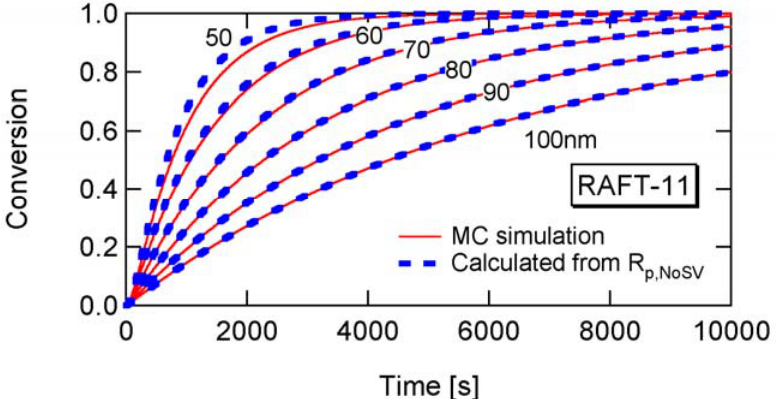
Figure 19. Conversion development of RAFT-11 with various particle sizes. The numbers in the figure show the particle diameter D < 60 nm. for D p